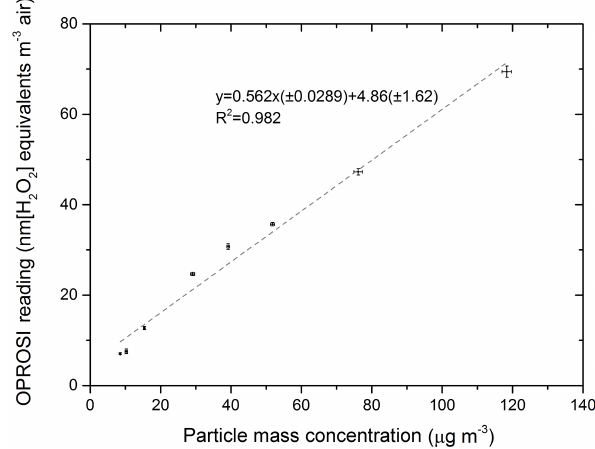
Figure 6. Data from α -pinene ozonolysis SOA laboratory experi- ment, showing the OPROSI response to changes in mass concentra- tion of oxidised aerosol. The time periods highlighted in grey were when a HEPA filter was in line, resulting in an OPROSI blank mea- surement.